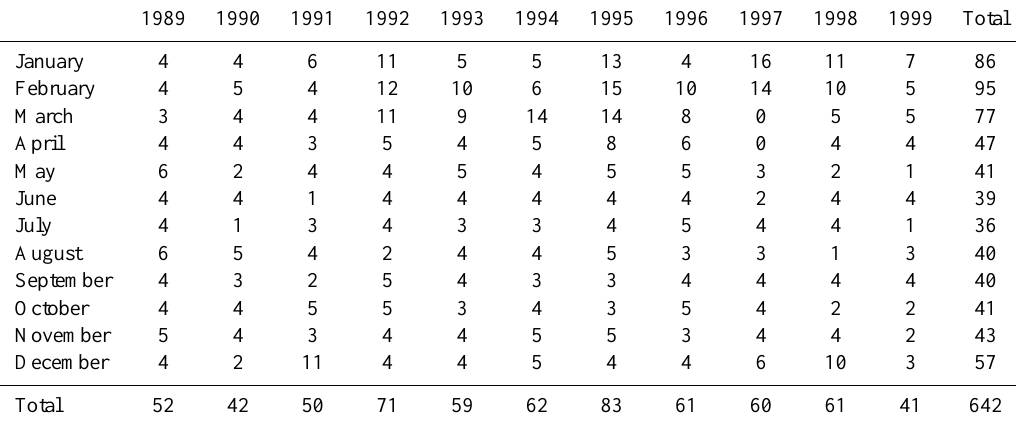
Table 1. Number of analyzed ozone sonde profiles.